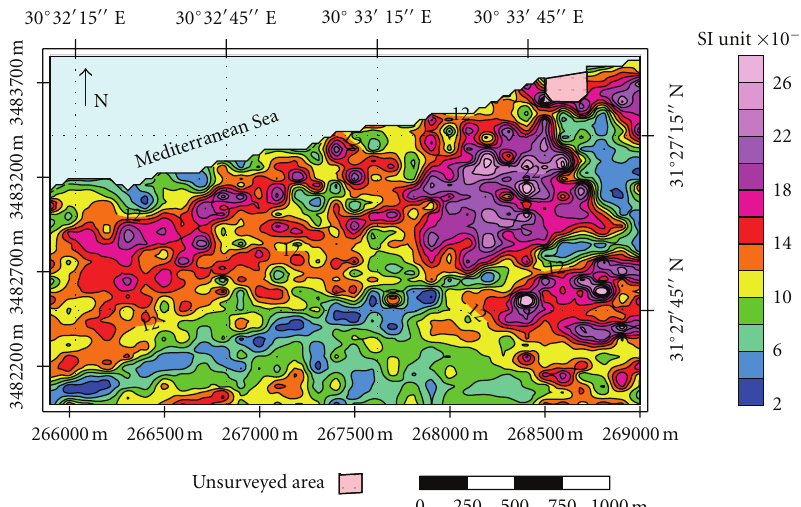
Figure 9: Filled colour contour map of field magnetic susceptibility (k f ) measurements, Koam Mashaal area, East Rosetta, Mediterranean Sea Coast, Northern Egypt. Contour interval = 2 ∗ 10 − 3 SI unit.